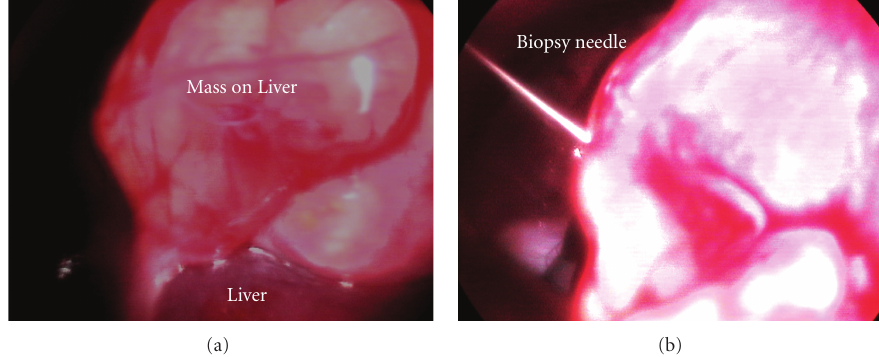
Figure 11: Laparoscopic-guided percutaneous Tru-Cut needle biopsy of hepatic mass in 8-year-old intact male Labrador Retriever dog.